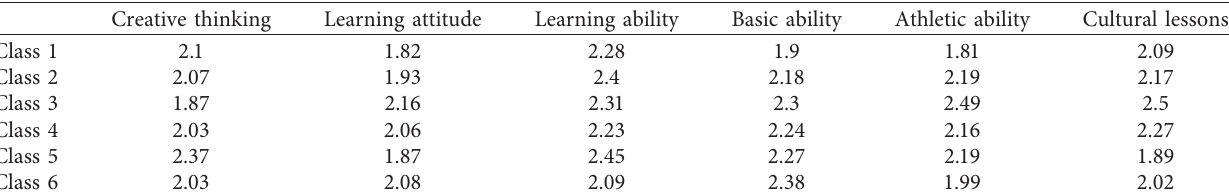
Table 1: Mastery of male